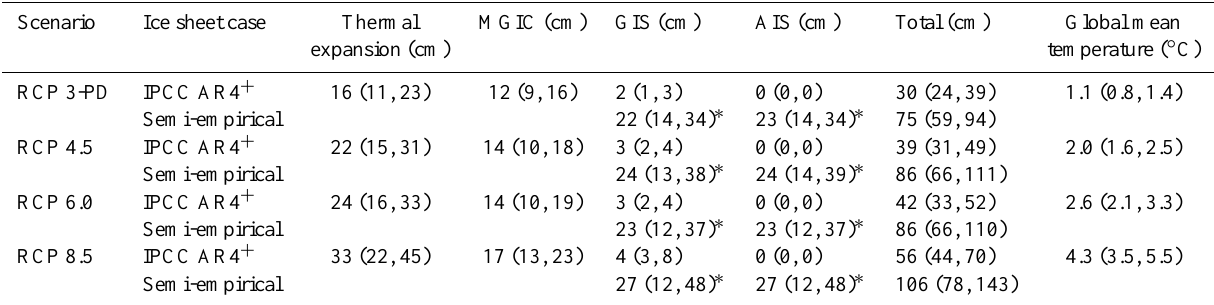
∗ indicate that ice sheet contributions are obtained from the semi-empirical approach (see main text)